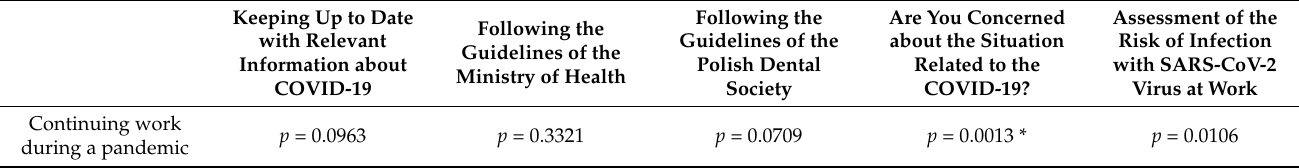
Table 6. Relationships between continuing work during a pandemic and selected parameters—evaluated using the Chi square